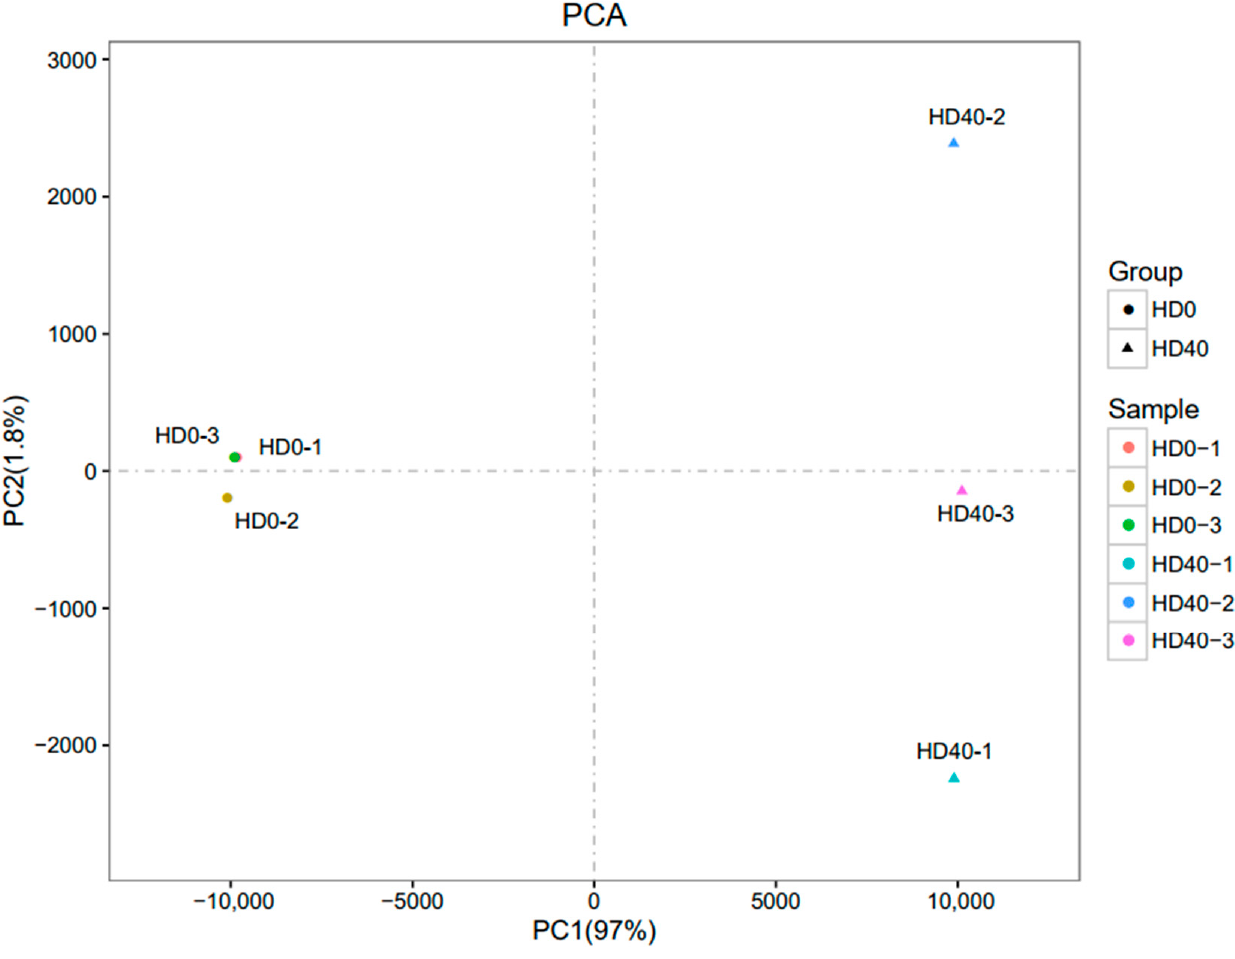
Figure 6. Principal component analysis (PCA) of samples’ relationship. The control groups (HD0- 1,2,3) are represented by the triangle nodes, while the 2,5-HD treated groups (HD40-1,2,3) are represented by the circle nodes. The two principal components, PC1 and PC2, together accounted for 98.8% of the total variance, with PC1 accounting for 97% and PC2 for 1.8%.